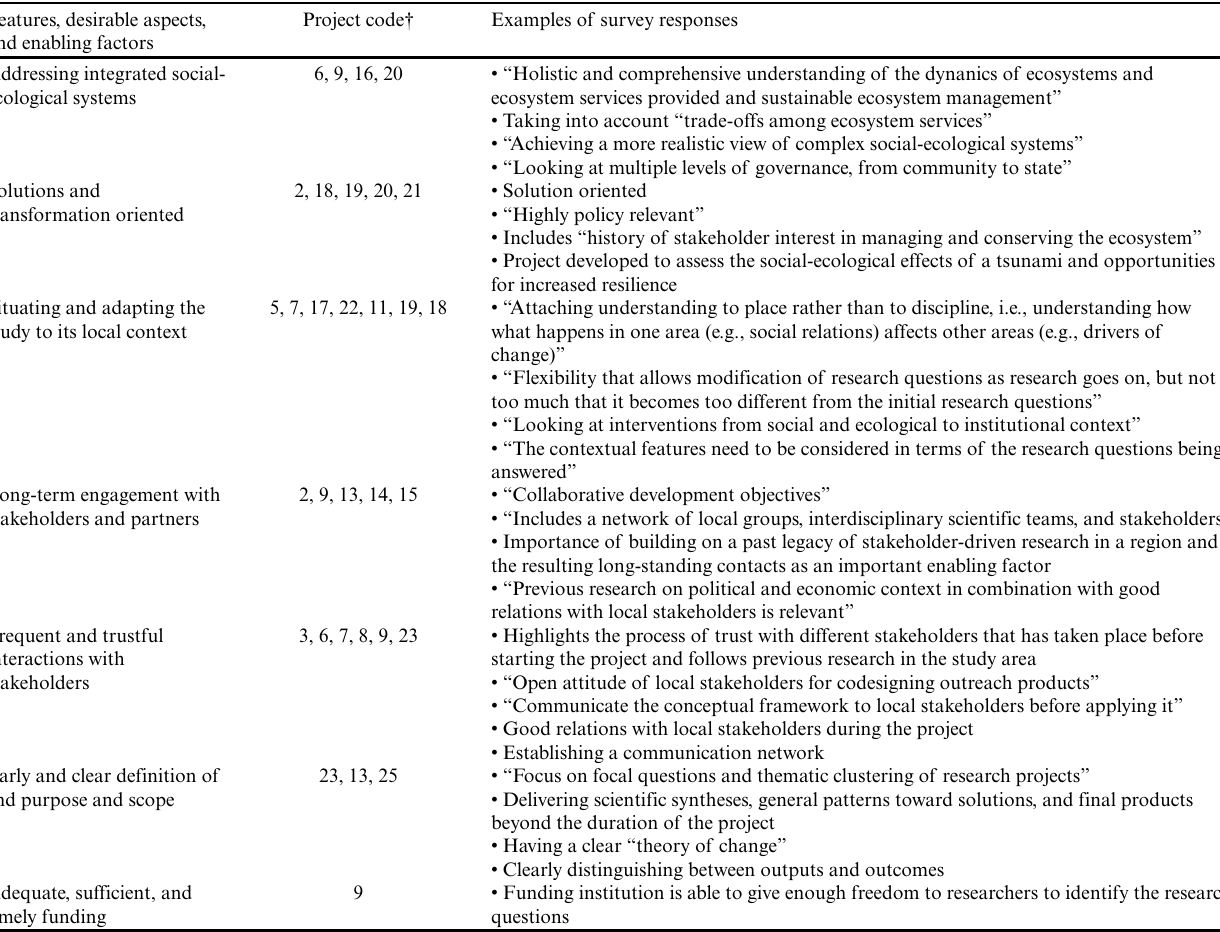
Table 2. Examples of features, desirable aspects of features, and enabling factors that contribute to the success of place-based social- ecological sustainability research based on the surveyed projects. Literal quotations are from interviews; other points are summaries of equivalent responses among